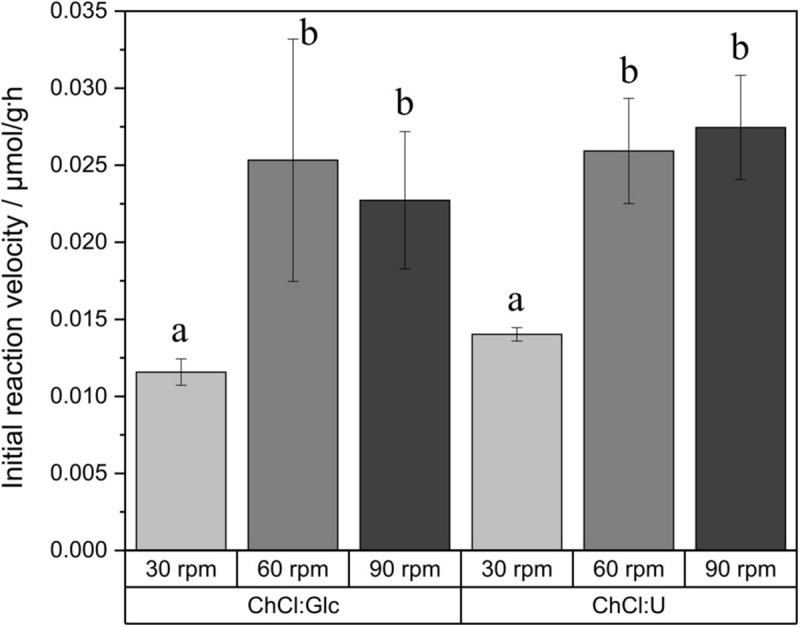
Initial reaction velocity in relation to the agitation rate. Glucose monodecanoate was determined directly by product quantification. Reaction conditions: 0.5 M vinyl decanoic acid, 50°C. a and b shows statistically significant differences. ChCl:Glc (ChCl:Glc:water, 5:2:5, n:n:n) and ChCl:U (ChCl:U, 1:2, n:n, 5% water).